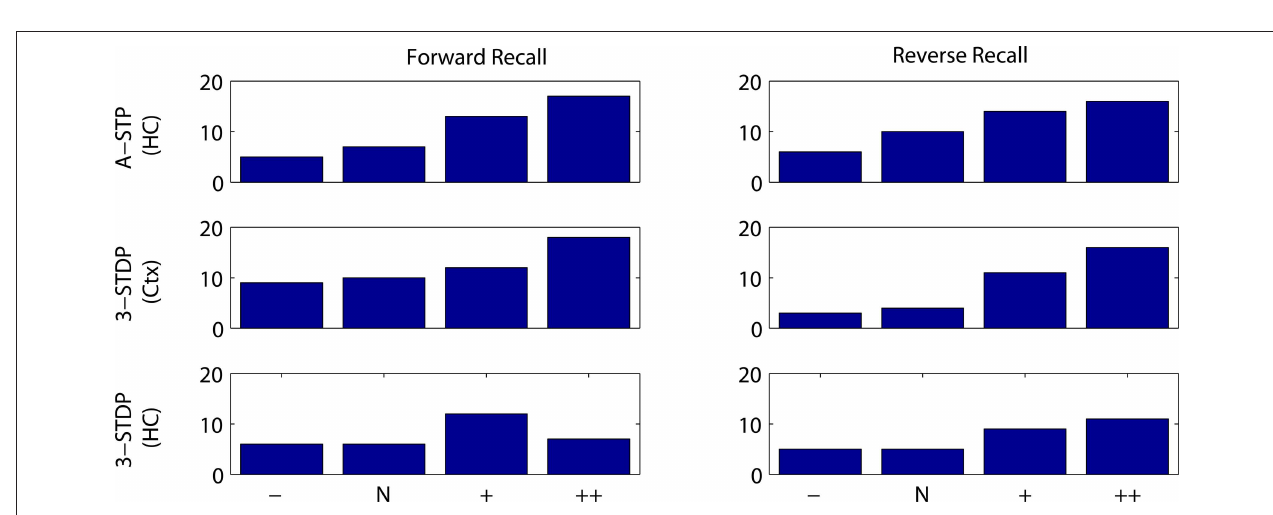
Figure 9 | Mean change in synaptic weights between cell groups as a function of duration of stimulus presentation and plasticity mechanism. Fractional change in synaptic strength is plotted . (Left) Connections needing strengthening for forward recall. W1–C1 = first word to context-1. C1–W2 = context-1 to second word. (Right) Connections needing strengthening for reverse recall. W2–C1 = second word to context-1. C1–W1 = context-1 to first word. Stimulus protocols are two